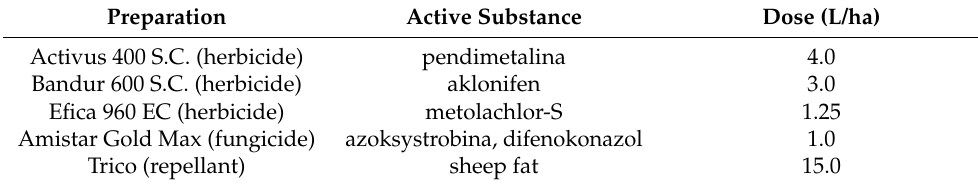
Table 2. Chemical plant